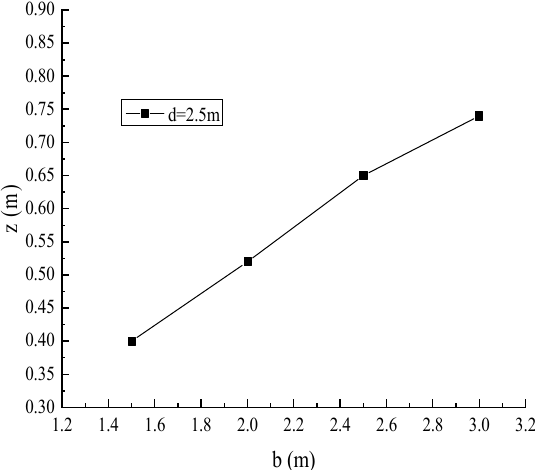
Figure 8. Influence of foundation width on safety depth.